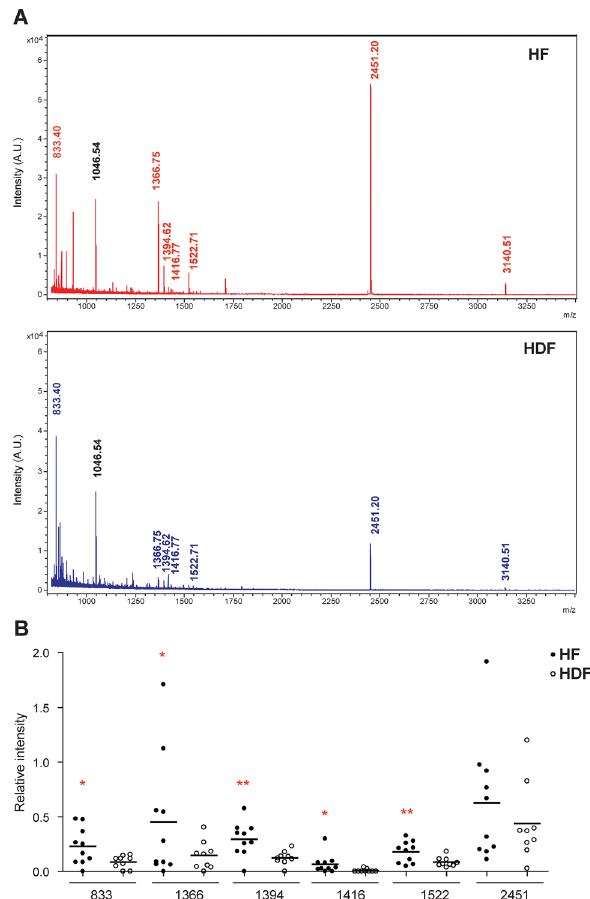
Figure 4. Mass spectra and quantification of transthyretin (TTR) peptides of HF and HDF paients by mass spectrometry. ( A ) Mass spectra of the TTR peptides from trypsin digestion obtained by MALDI-TOF MS. The spectra show the m/z peaks corresponding to human TTR peptides from HF (red) and HDF (blue) samples and the angiotensin-II peptide, added as internal standard (black). Peptide intensities in arbitrary units (A.U.); m/z values of MH + peaks of TTR peptides and angiotensin-II are indicated. ( B ) TTR peptides, with MH + peaks at m/z 833.40, 1,366.75, 1,394.62, 1,416.77, 1522.71 and 2,451.20 were quantified with respect to the angiotensin-II peptide (internal standard) as relative intensities (ratio TTR peptide intensity/angiotensin-II intensity). The graph shows the quantified levels of each TTR peptide for individual HF and HDF samples. Data represent individual values and horizontal lines represent the mean. * p < 0.05 and ** p < 0.01, HF group compared with HDF group by